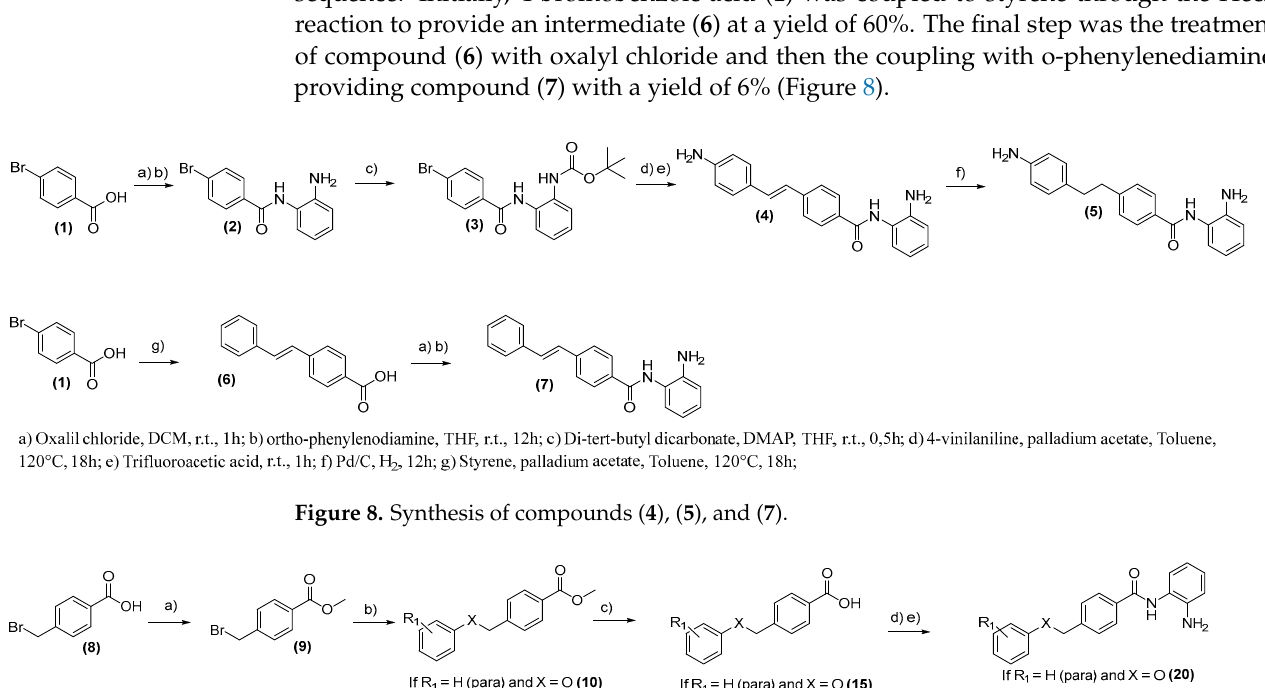
Figure 9. Synthesis of compounds ( 20 )–( 24 ).